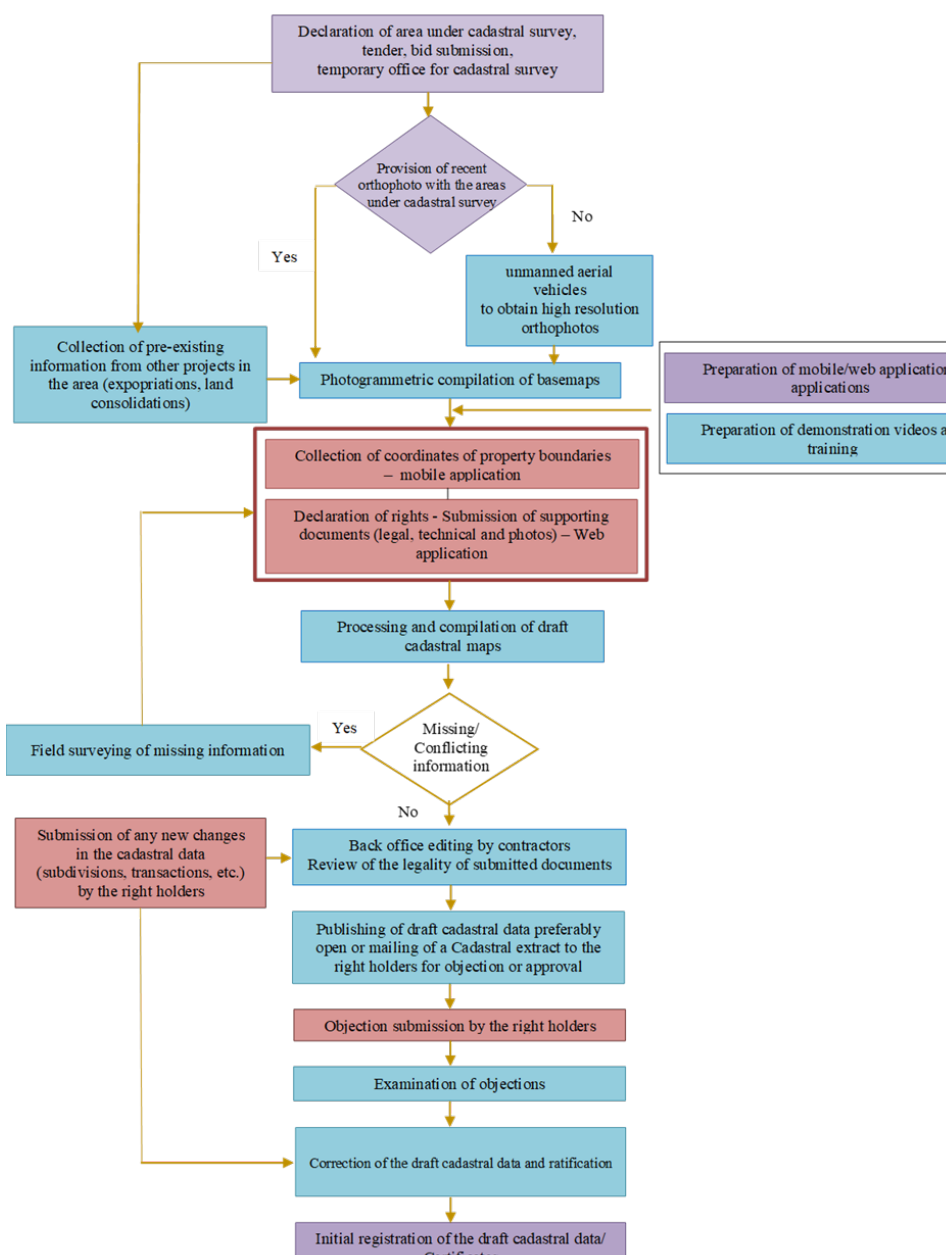
Figure 5. Main stages of the proposed procedure (stages in purple color depict state agency actions; stages in blue color depict contractors’ actions; stages in pink color depict right holders’ actions). Right holders may either ‘visit’ the property on site and delineate the parcel boundaries on the basemap, by digitizing the parcel polygon, or if they can recognize their parcel on the orthophoto, they may digitize the boundaries from a distance. Recent work in this field has shown that the boundaries that could be visible on the basemap and were digitized using smart phones had similar geometric accuracies with those produced by the formal surveying procedures, while invisible on the basemap parcel boundaries that have been digitized using the GNSS of the smartphone had much lower geometric accuracies